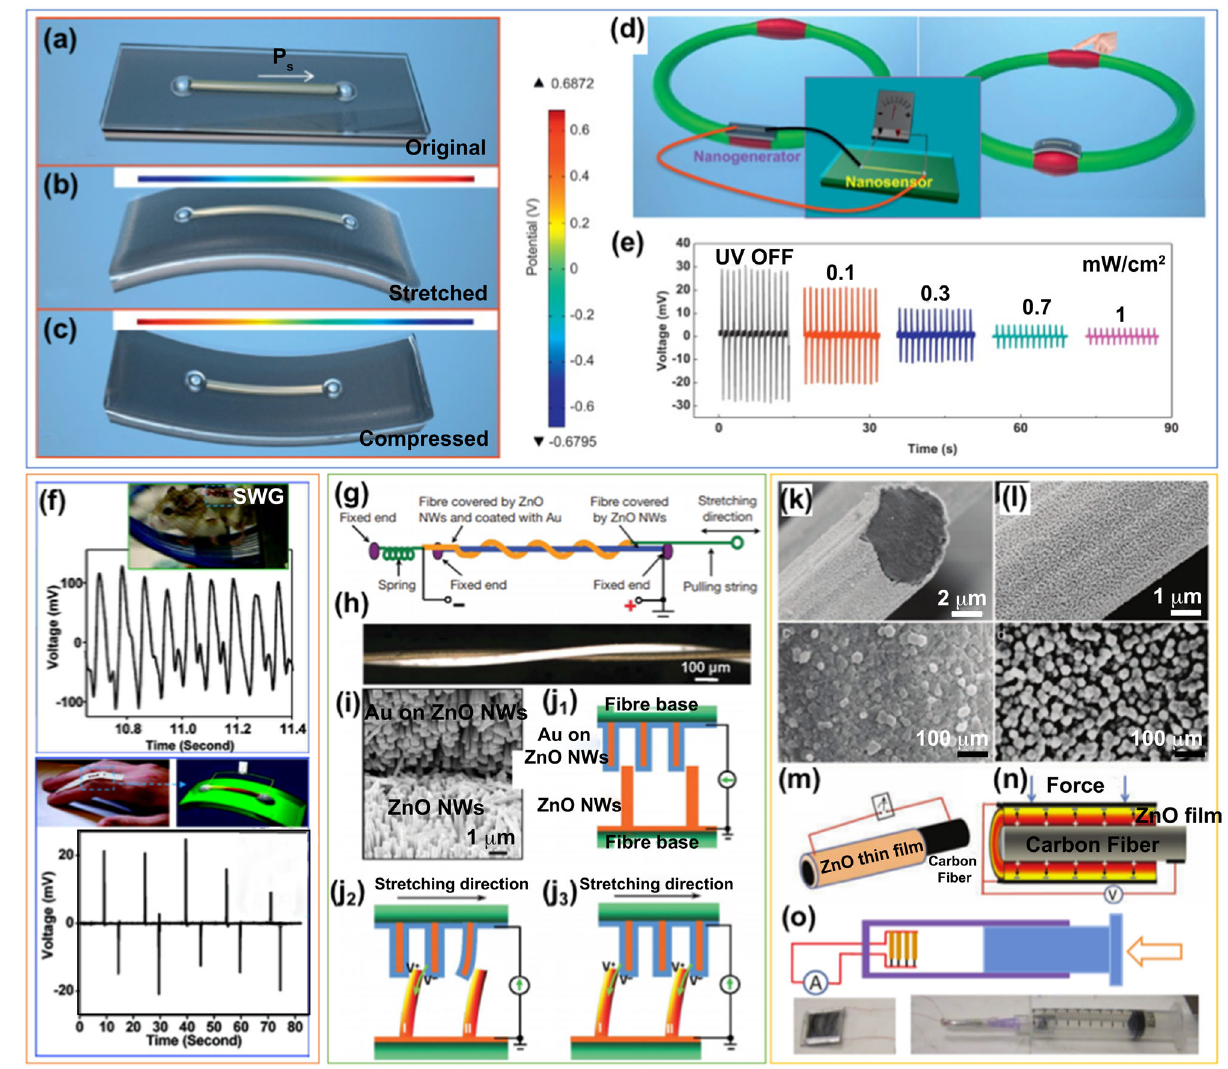
Fig. 3 Piezoelectric energy generators. a 3D schema of a single NW-based piezoelectric nanogenerator fabricated on a fl exible substrate and subjected to b stretching and c compression conditions. d 3D schema presenting the working principle of a self-powered touch nano-sensors powered by a piezoelectric nanogenerator a – c . Reprinted with permission from Bai et al. 114 Copyright © 2012 Elsevier Ltd. f Energy harvesting from a (top) rat running and (bottom) an oscillating human index fi nger using a single nanowire-based nanogenerator, namely SWG, including the I – V characteristics. Reprinted with permission from Yang et al. 55 Copyright © 2009, American Chemical Society. g 2D schema, h optical micrograph and i SEM image of a nanogenerator based on fi bre-NW heterostructure. j 1 – j 3 2D schema of piezoelectric generation working principle. Reprinted with permission from Qin et al. 119 Copyright © 2008, Springer Nature. k , l SEM images of ZnO fi lm coating carbon fi ber. m , n 3D Schema of a fi ber-based nanogenerator. o Schema and pictures of air pressure driven nanogenerator when it is placed inside a syringe. Reprinted with permission from Li et al. 120 Copyright © 2010, John Wiley and